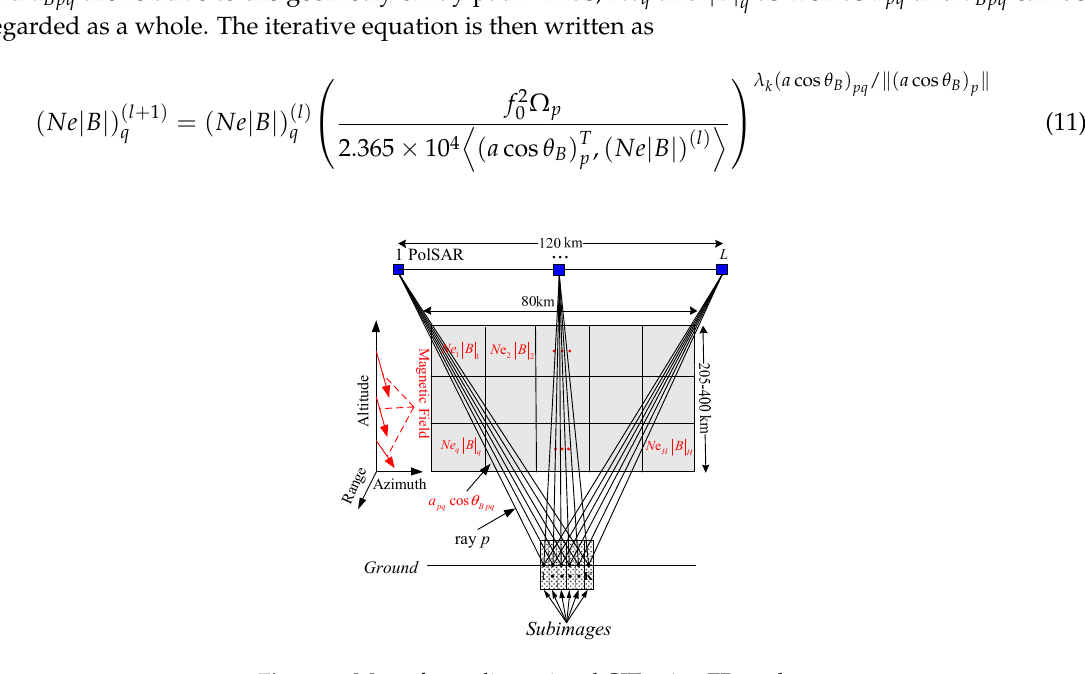
Figure 1. Map of two-dimensional CIT using FR angles.